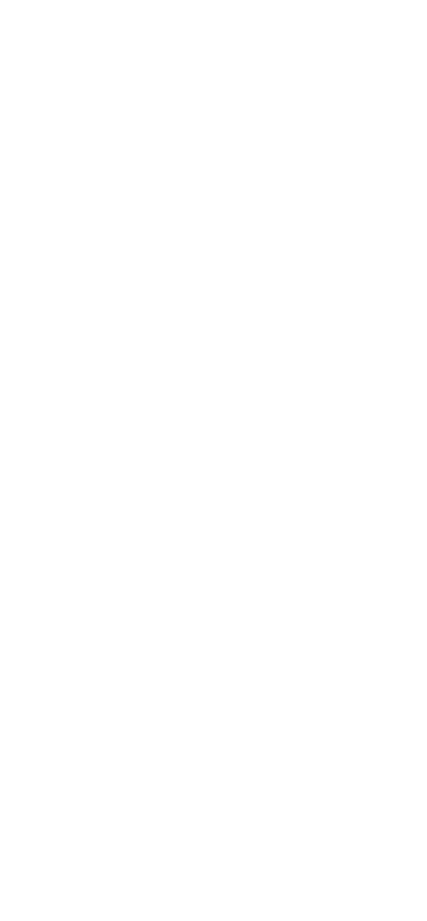
FIGURE 6 | Oocyte size (diameter in µm), gonadosomatic index (GSI, %), hepatosomatic index (HSI, %), Fulton ’ s condition factor (K), age (years), and somatic fat (%) of female Paci fi c halibut according to the reproductive phase. For each parameter, statistical signi fi cance (p < 0.05, Kruskal-Wallis) was denoted with an * in the y-axis title, with different letters indicating statistically signi fi cant (p < 0.05, Dunn ’ s post hoc ) differences among groups (e.g. “ a ” is different from “ b ” but not from “ ab ” ), and with the sample size displayed above the boxes. Regressing phase, denoted by †† , contains 21 PS stage fi sh as identi fi ed by presence of POFs and, therefore, oocyte diameters are representative of the CA oocytes which in this case are not the most advanced